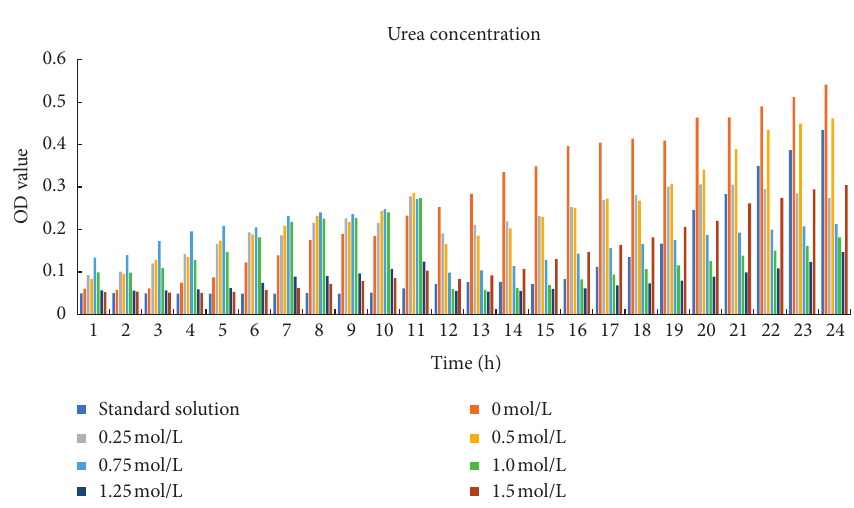
Figure 2: Effects of urea concentration on Bacillus sphaericus